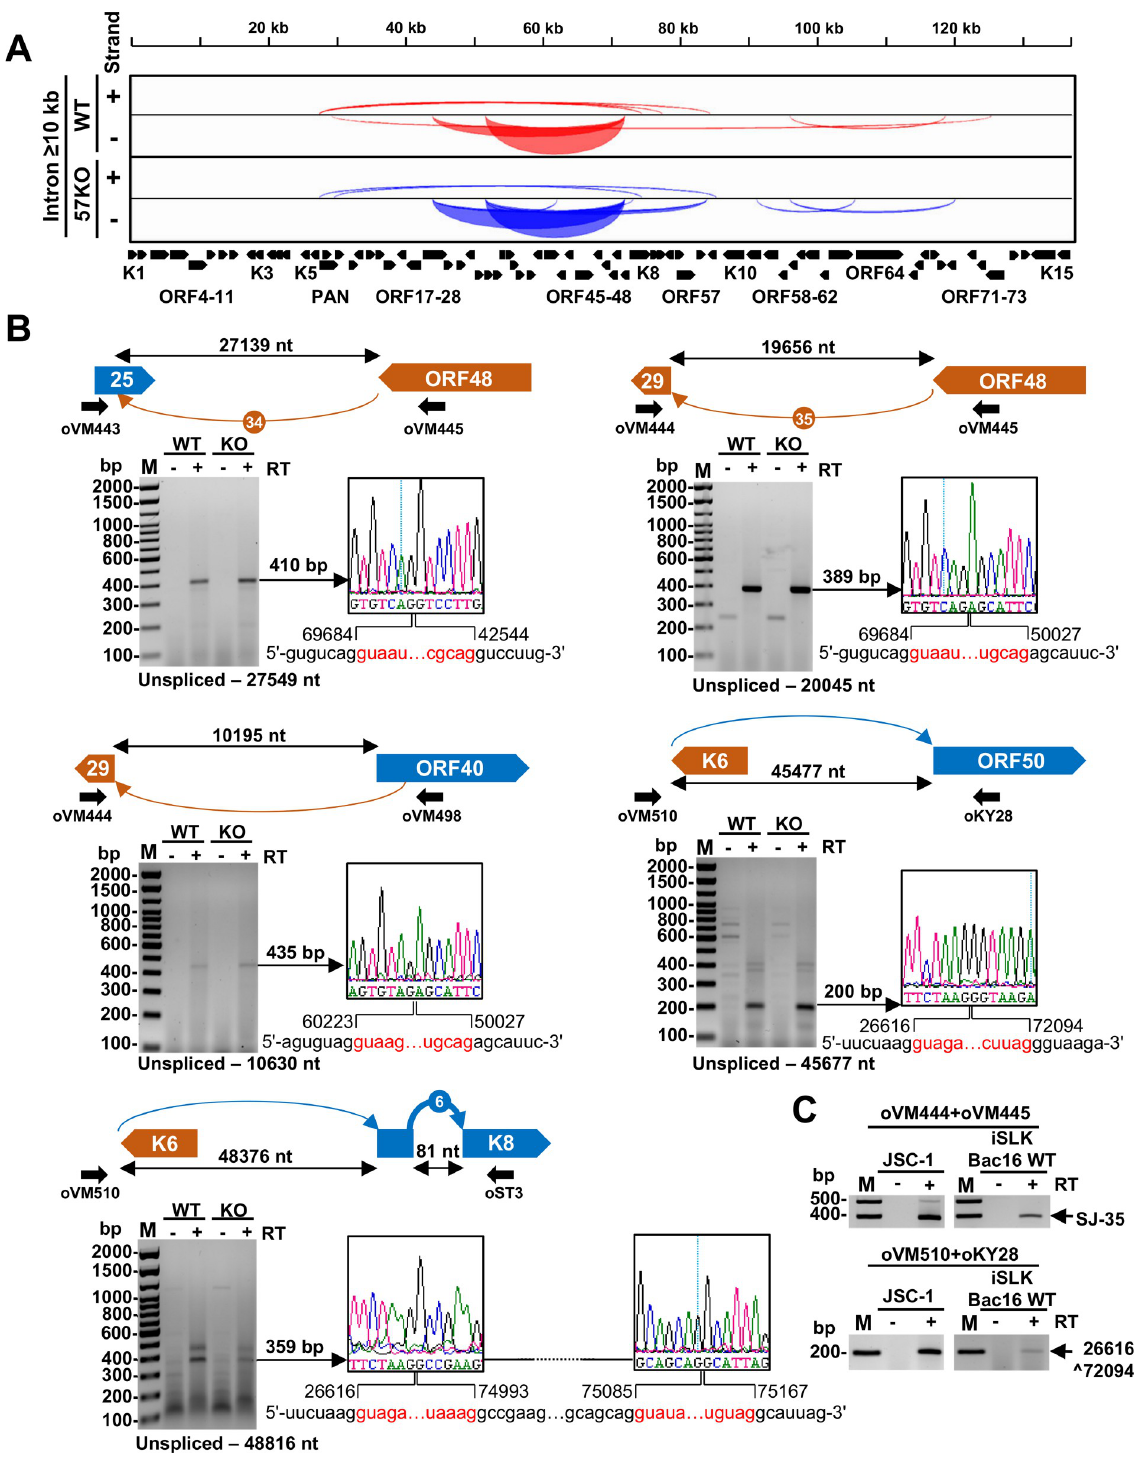
Fig 7. Long-range KSHV RNA splice identified in BCBL-1 cells with lytic KSHV infection. (A) The Sashimi plot showing all splice junctions with an intron size � 10 kb supported with at least 2 splice junction reads. See S2 Table for details. (B) Validations of selected long- range RNA splicing events by RT-PCR on total RNA from the WT genome or 57KO genome in the cells with lytic KSHV replication induced by VA for 24 h. Above the gel is a schematic showing a selected splicing event in orange arches for minus DNA strand-derived RNA transcripts and blue arches for plus DNA strand-derived RNA transcripts, relative genomic locations, predicted intron sizes, and primers used